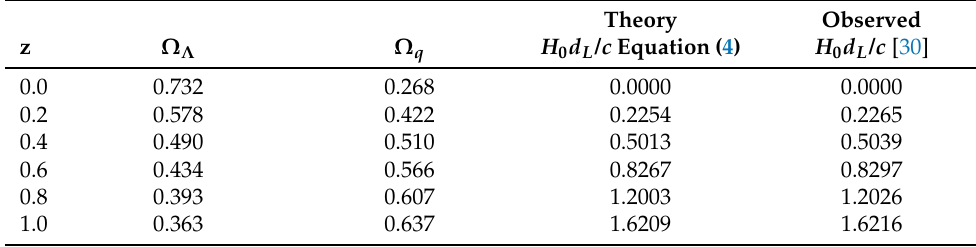
Table 1. Scaled luminosity distance fit to Hubble data.